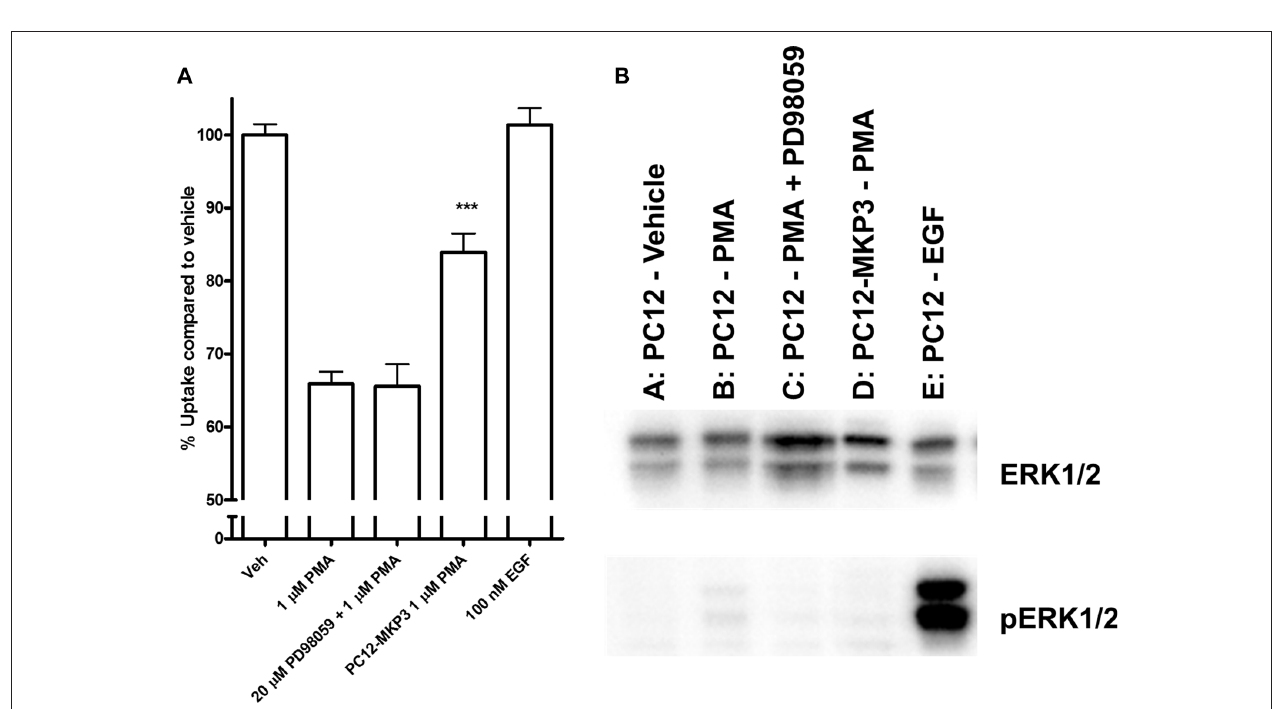
FIGURE 4 | Downstream activation of extracellular-signal-regulated kinase (ERK)1/2 does not mediate the effect of PKC activation on NET activity. Naïve or MKP3-expressing (PC12-MKP3) PC12 cells were pretreated for 30 min with PKC activator PMA (1 µ M), MEK1/2 inhibitor PD98056 (20 µ M), or EGF (100 nM)